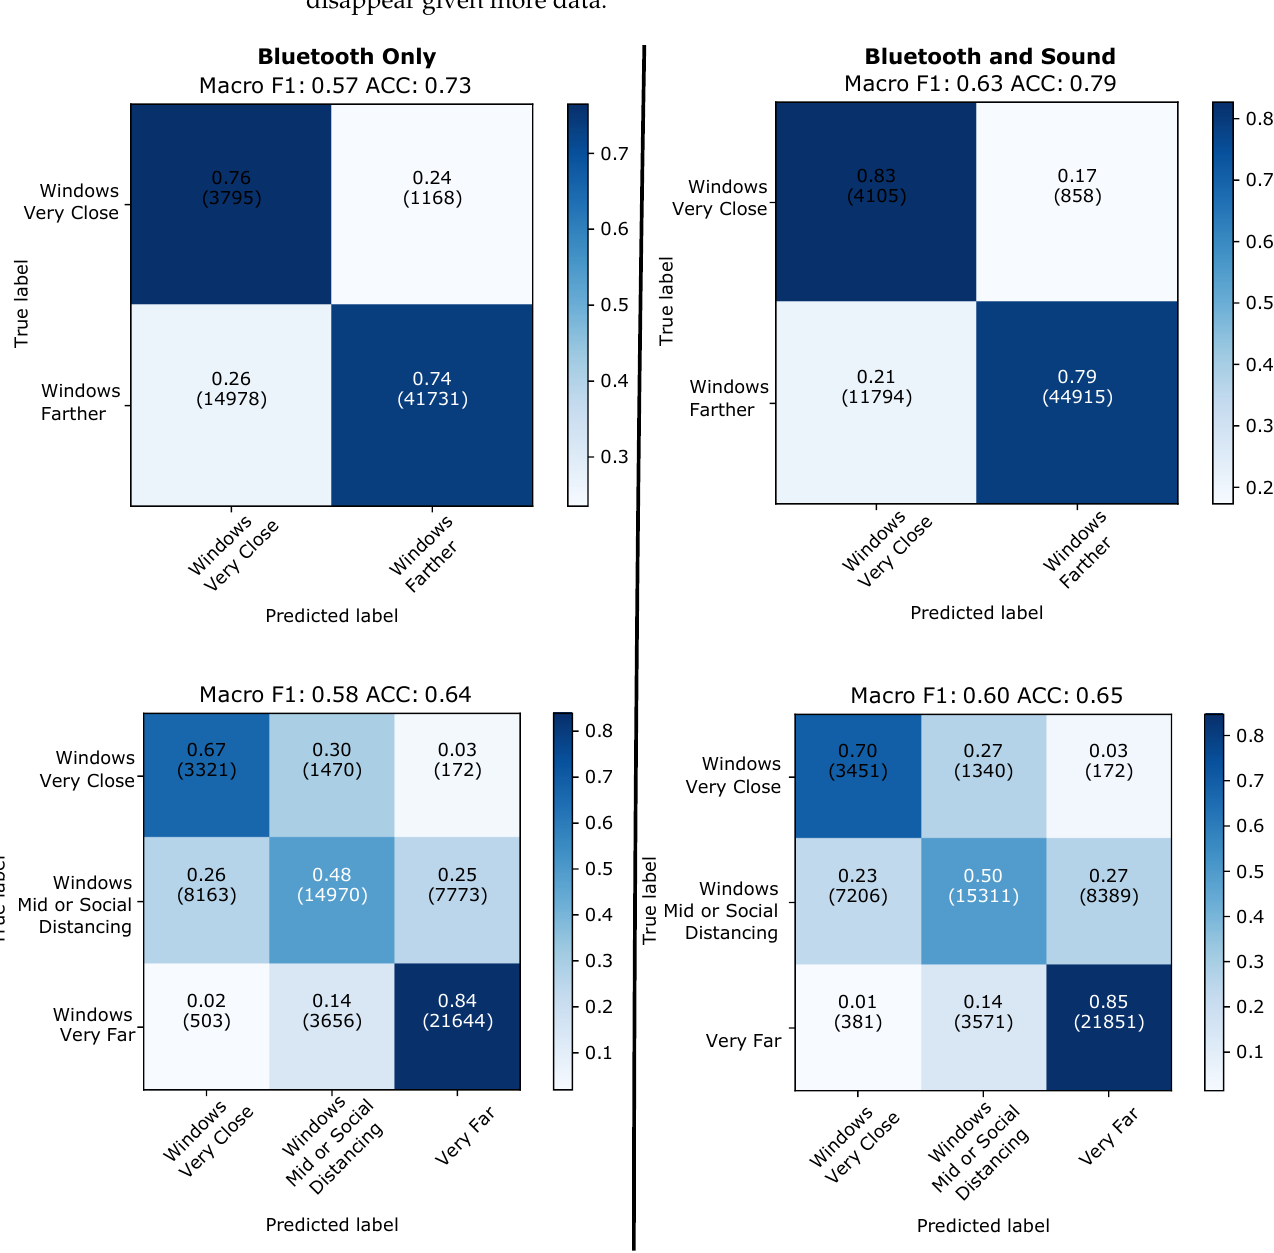
Figure 15. Leaving-one-day-out. Results of aggregation over 4 min taking into account all windows (with and without